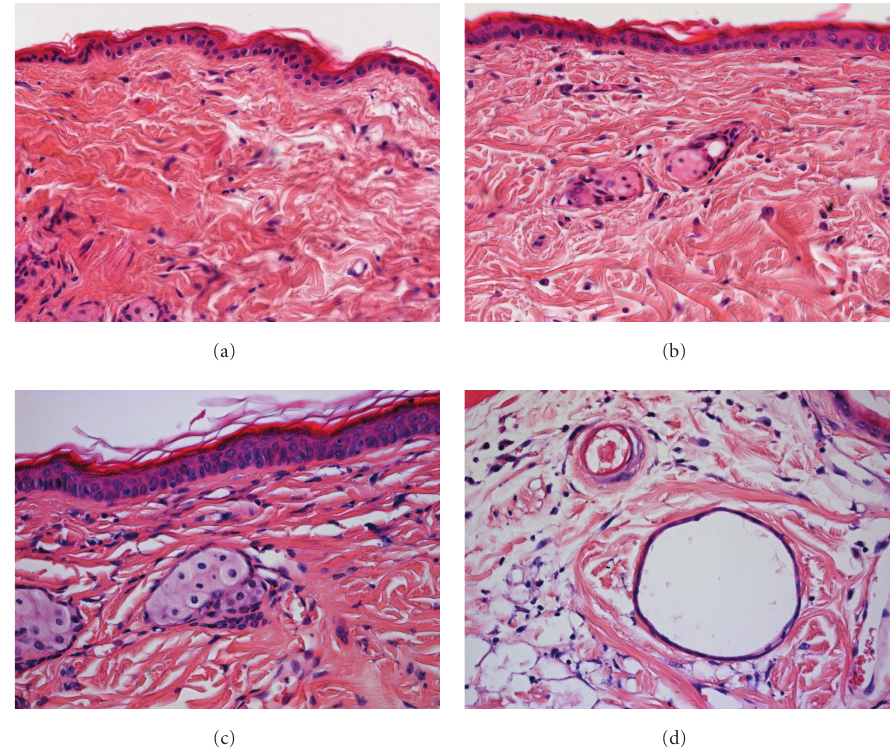
Figure 3: Photomicrographs of the skin from groups 2, 5, and 1, respectively, (H&E staining). (a) Group 2, treated with ibuprofen-free gel. (b) Group 5, exposed to ibuprofen-containing gel. (c) Group 1; no treatment was applied. (d) Atrophic folliculus.